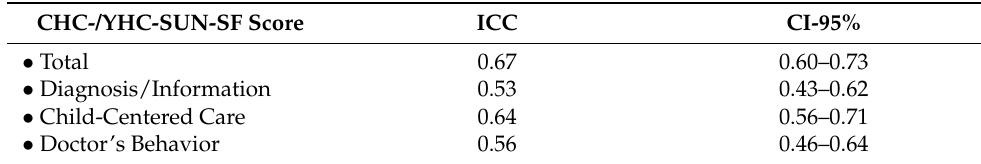
Table 4. Intraclass-correlation coefficients between self-report and parents report scores for overall scale and sub-scales of the CHC-/YHC-SUN-SF ( n =